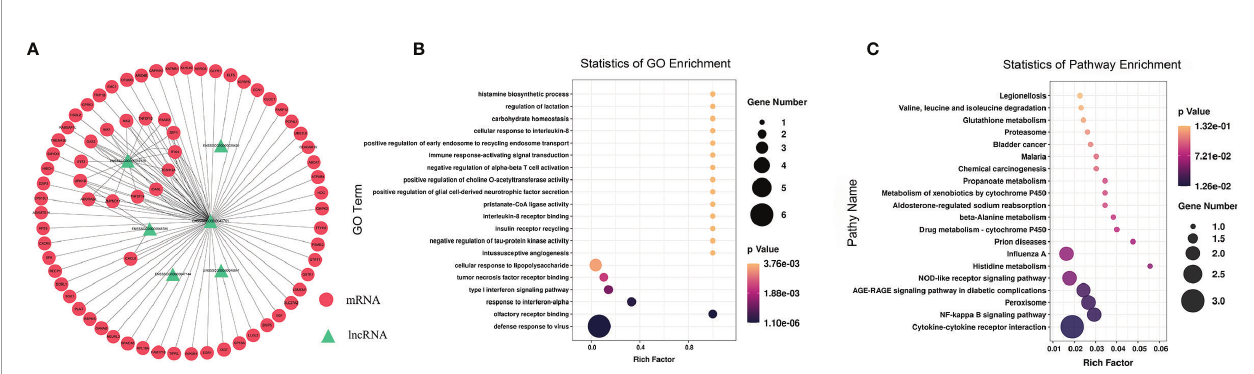
FIGURE 7 | Combined analysis of lncRNAs in the RNA-seq and MeRIP-seq data. The network between differentially expressed m6A-modi fi ed lncRNAs and differentially expressed mRNAs (A) . The red circles represent signi fi cantly differentially expressed mRNAs, and the green triangles represent signi fi cantly differentially expressed m6A- modi fi ed lncRNAs. GO enrichment (B) and KEGG signaling pathway analysis (C) of differentially expressed target genes of differentially m6A-modi fi ed